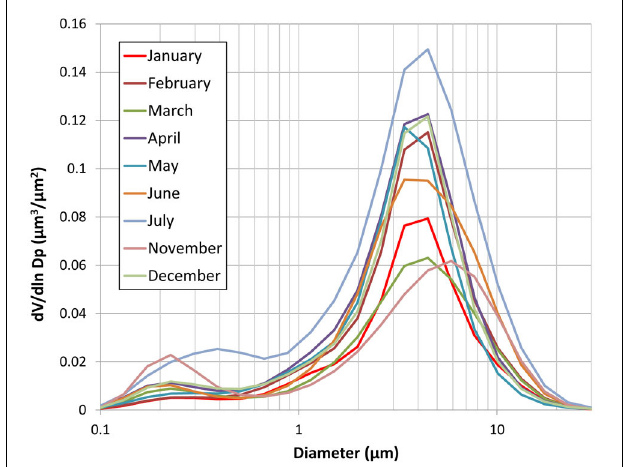
FIGURE 13 | Monthly averaged, column integrated, volumetric size distributions retrieved from AOD measurements in AERONET station at Sal Island, Cape Verde. No data is available for